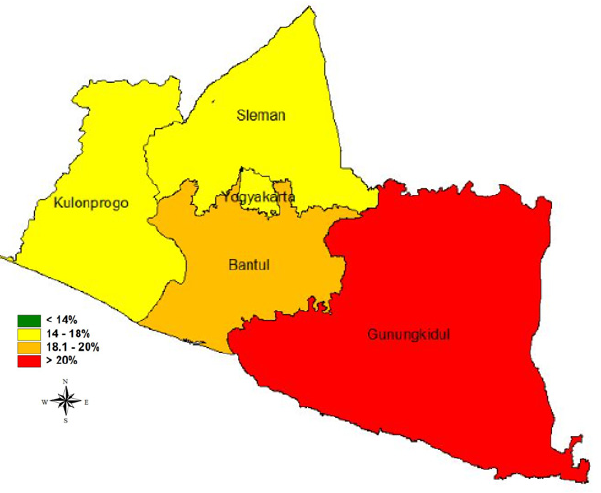
Figure 1. Map of stunted children under five in Yogyakarta Province, 2021.